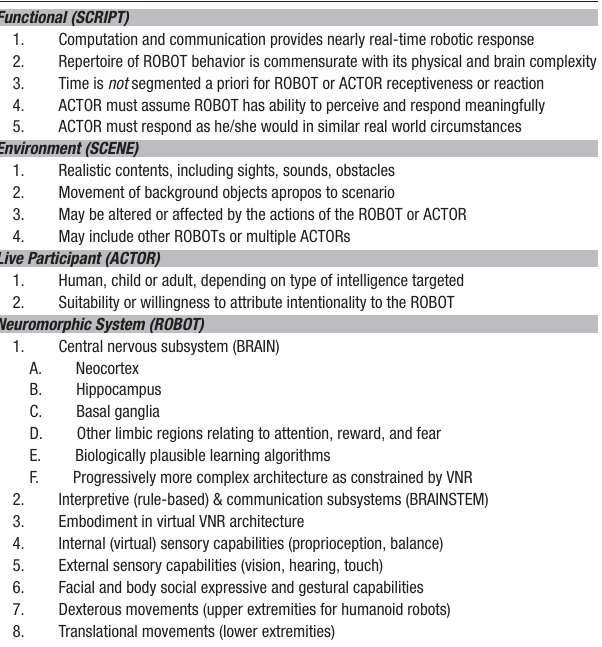
Table 1 . Components of a closed-loop neuromorphic brain